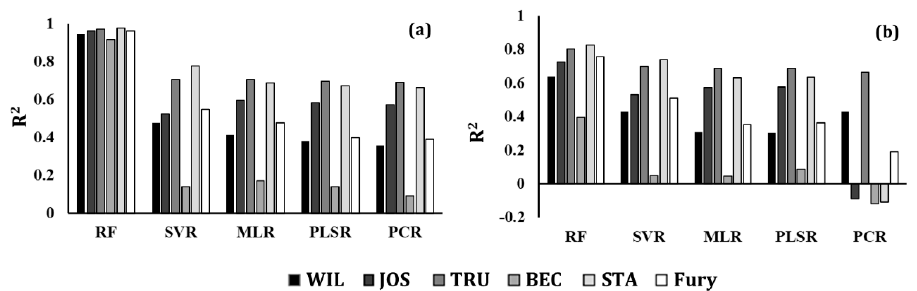
Figure 4. R 2 values of the individual predictive models on the AB-transformed data of the ( a ) calibration and ( b ) validation sets.